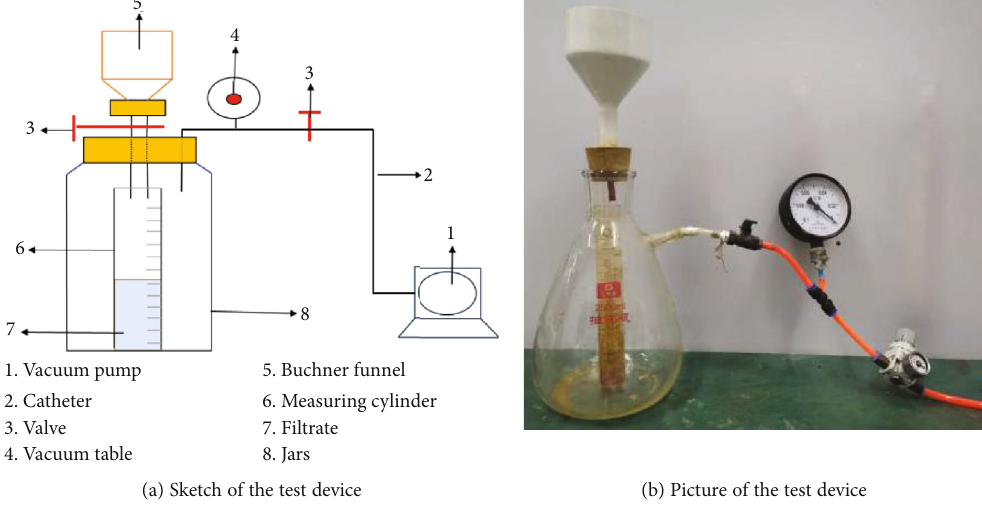
Figure 2: Speci fi c resistance test device.